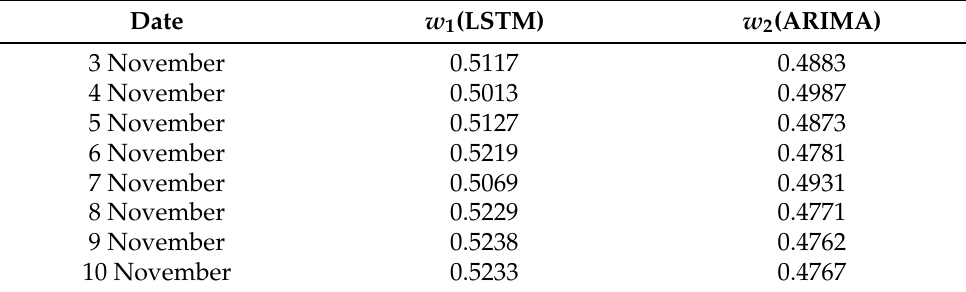
Table 2. Weights of single model based on entropy